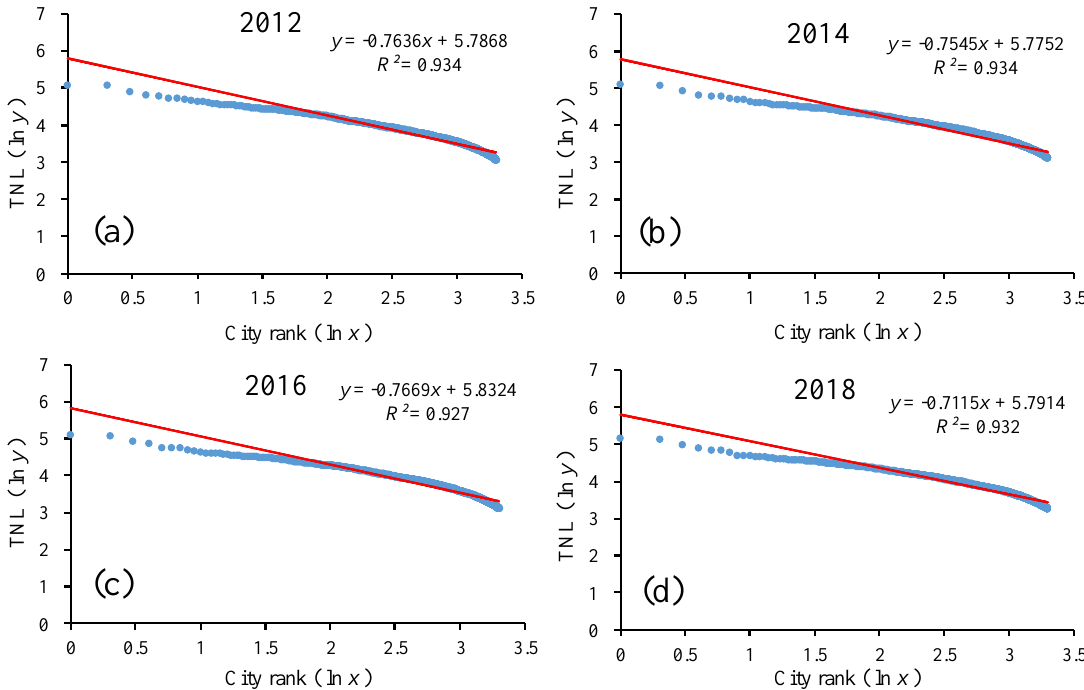
Figure 12. The ln-ln plot of the rank–size of the urban development for the top 2000 counties. Line regression of ( a ) TNL and ranking of the top 2000 counties in 2012; ( b ) TNL and ranking of the top 2000 counties in 2014; ( c ) TNL and ranking of the top 2000 counties in 2016; ( d ) TNL and ranking of the top 2000 counties in 2018.